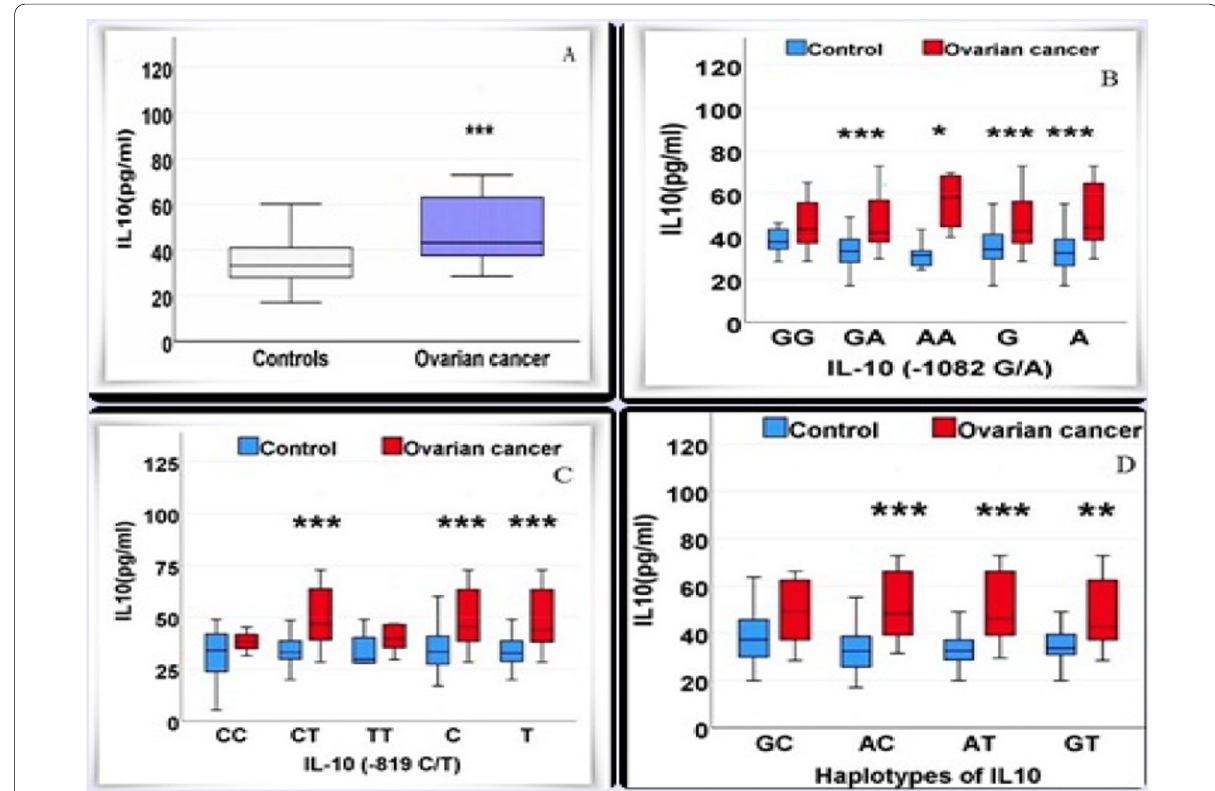
Fig. 4 IL10 levels (pg/ml) in connection to A control and OC groups, B IL10 ( ( 819 C/T) genotypes and alleles in healthy and OC groups, and D IL10 haplotypes in healthy and OC groups. Results are given as the mean − standard error. *** p < 0.001; ** p < 0.01; * p < 0.05. Box plots are used to display the data, with the 10th and 90th percentiles indicated by the lines outside the boxes, the medians by the lines inside the boxes, and the 25th and 75th percentiles by the